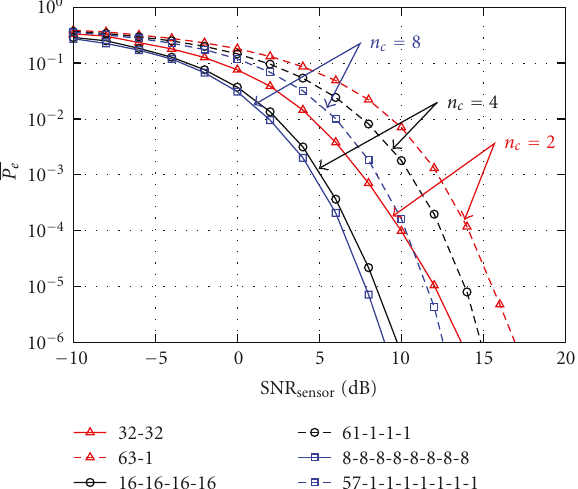
Figure 8: P e as a function of the SNR, in a scenario with n = 64 and di ff erent clustering configurations with 4 FCs. Two scenarios are considered: p = 0 and p = . 1.